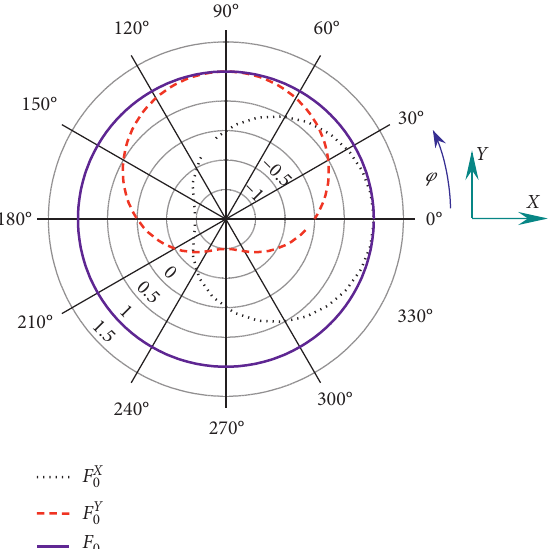
Figure 4: The relationship between the normalized yield strength of the isolator ( F respectively) for different directions (angle, φ , measured from the X -axis) of the resultant isolator